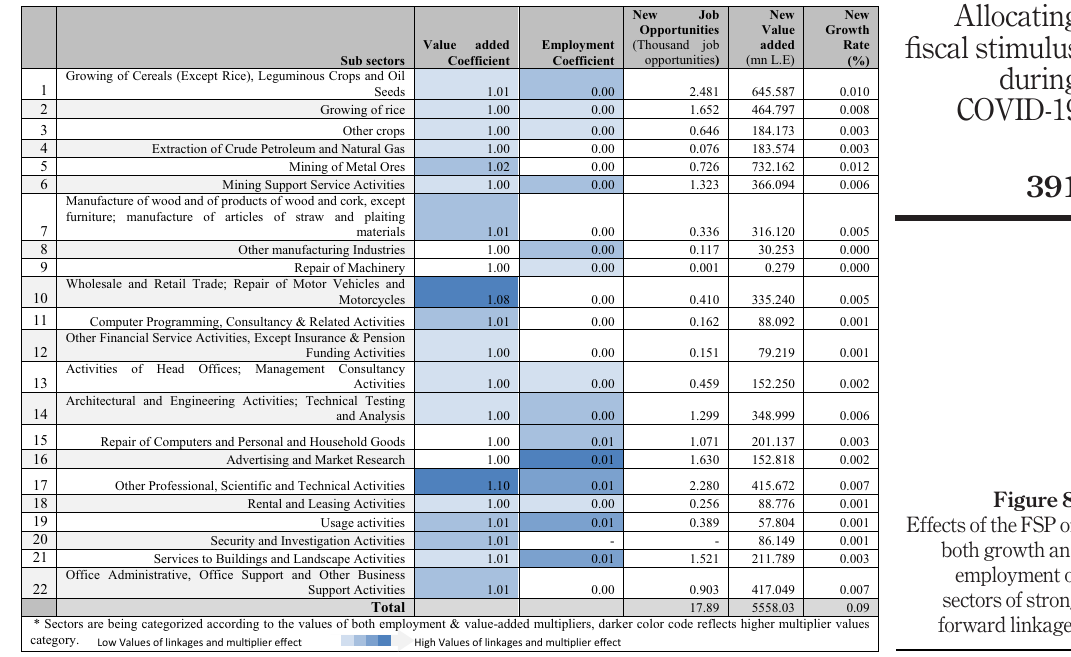
Figure 8. Effects of the FSP